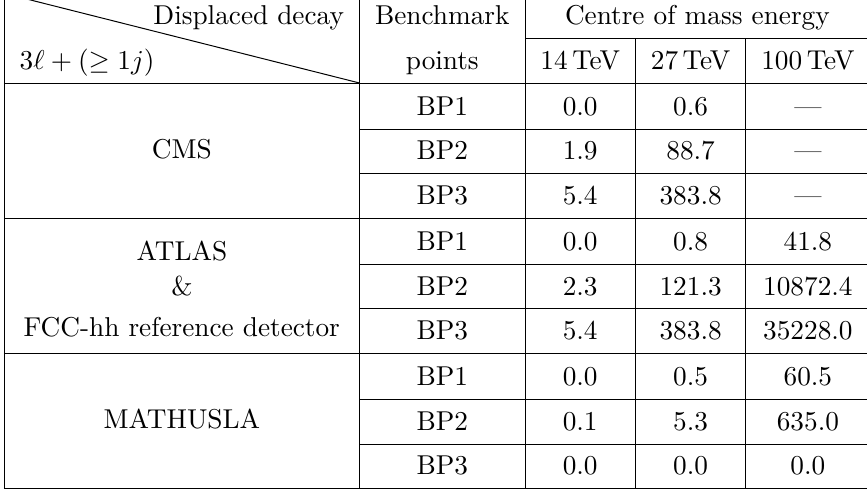
Table 9. Number of events in 3 ‘ + ( ≥ 1 j ) final state for the benchmark points with the center of mass energies of 14 TeV, 27 TeV and 100 TeV at the integrated luminosities of 3 ab − 1 , 10 ab − 1 and 30 ab − 1 , respectively. The numbers are given separately for CMS, ATLAS, FCC-hh reference detector (for 100 TeV) and